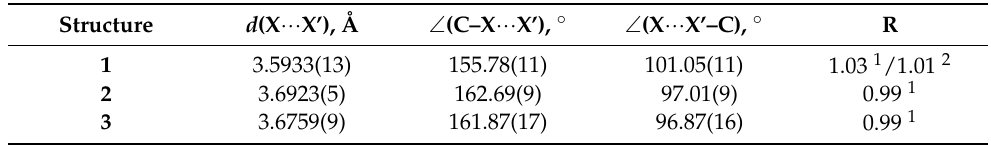
Table 1. Characteristic parameters of C–X ··· X’–C HaBs in 1 – 3 .